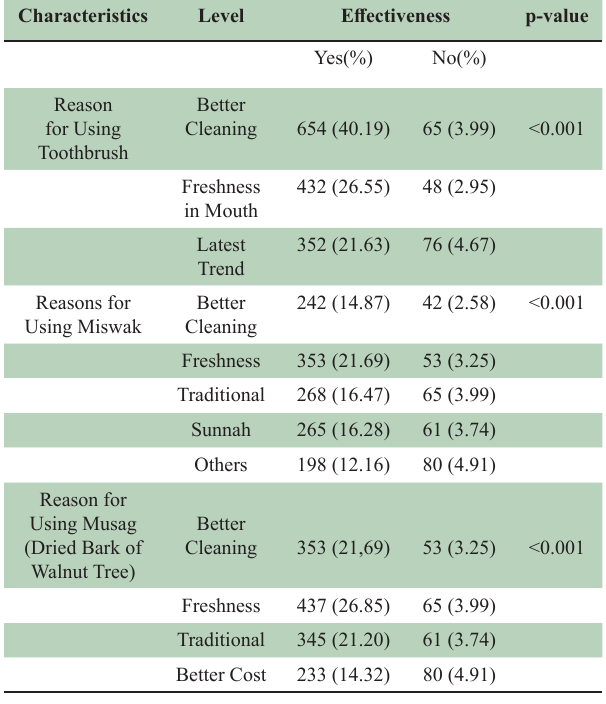
Table-IV: Characteristics of different tooth cleaning methods.